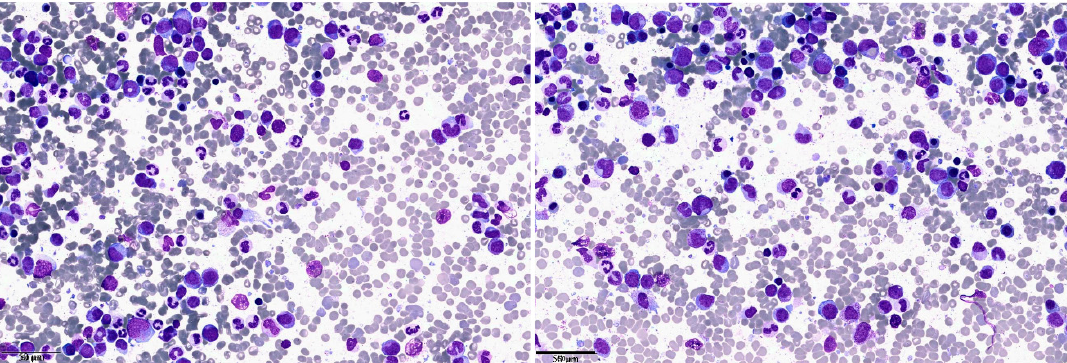
Figure 5. Bone marrow smears after 3 cycles of decitabine of clinical case 1. The reduction of marrow blasts with persistence of trilineage dysplasia and a residual thrombocytopenia are consistent with an optimal marrow response according to proposed international criteria [36]